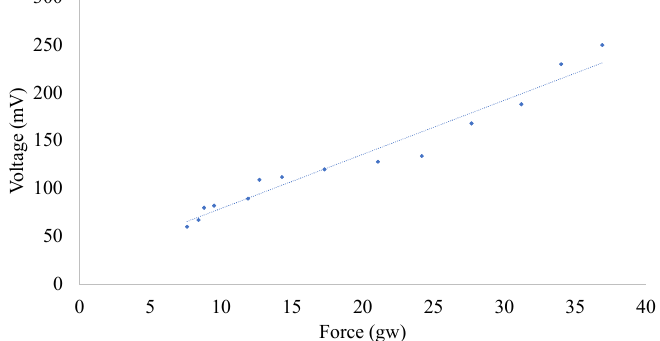
Figure 7. Sensitivity ratio of self-powered strain sensors for force (gw) and voltage (mV).